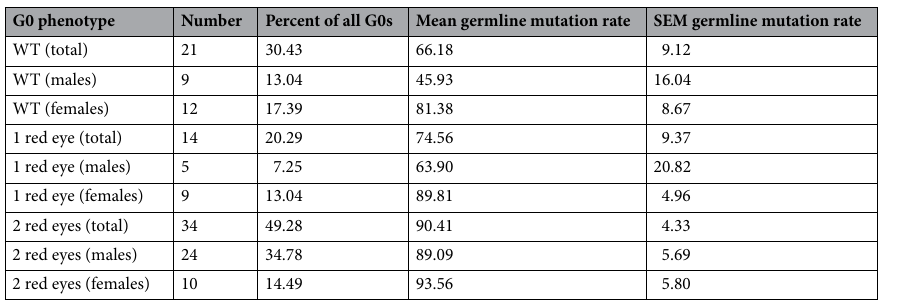
Table 2. Somatic and germline mutation rates observed in second Of-v CRISPR